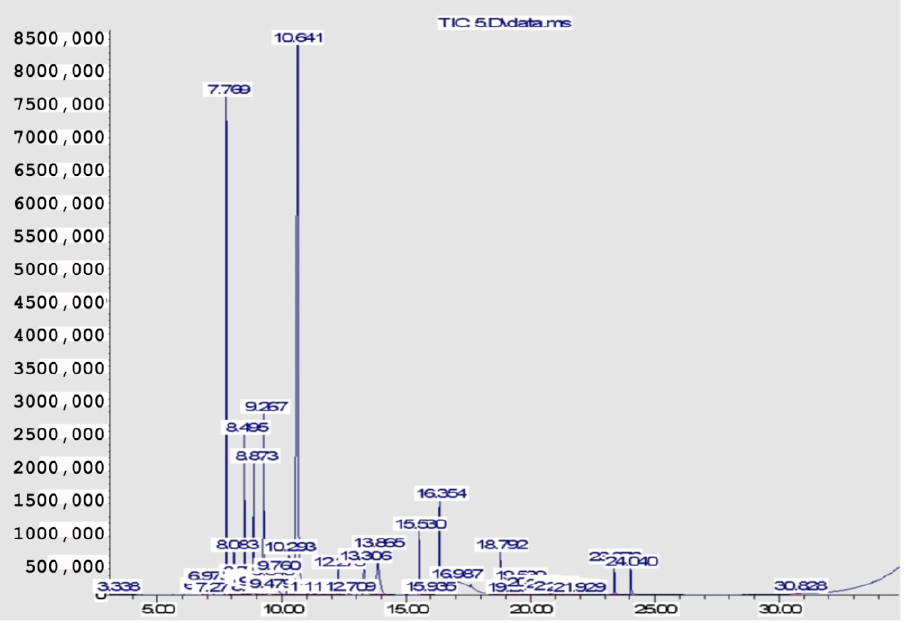
Figure 3. GC chromatogram of C. limon (SFME).